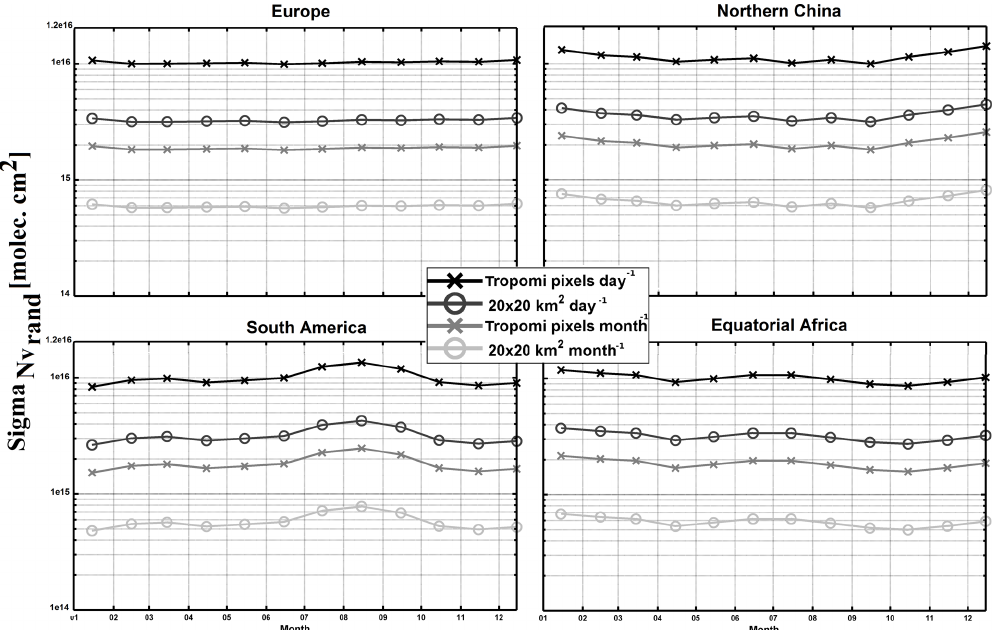
Figure 11. Estimated precision on the TROPOMI HCHO columns, in several NMVOC emission regions and at different spatial and temporal scales (from individual pixels to monthly averages in 20 × 20km 2 grids). These estimated are based on OMI observations in 2005, using observations with an effective cloud fraction lower than 40%.